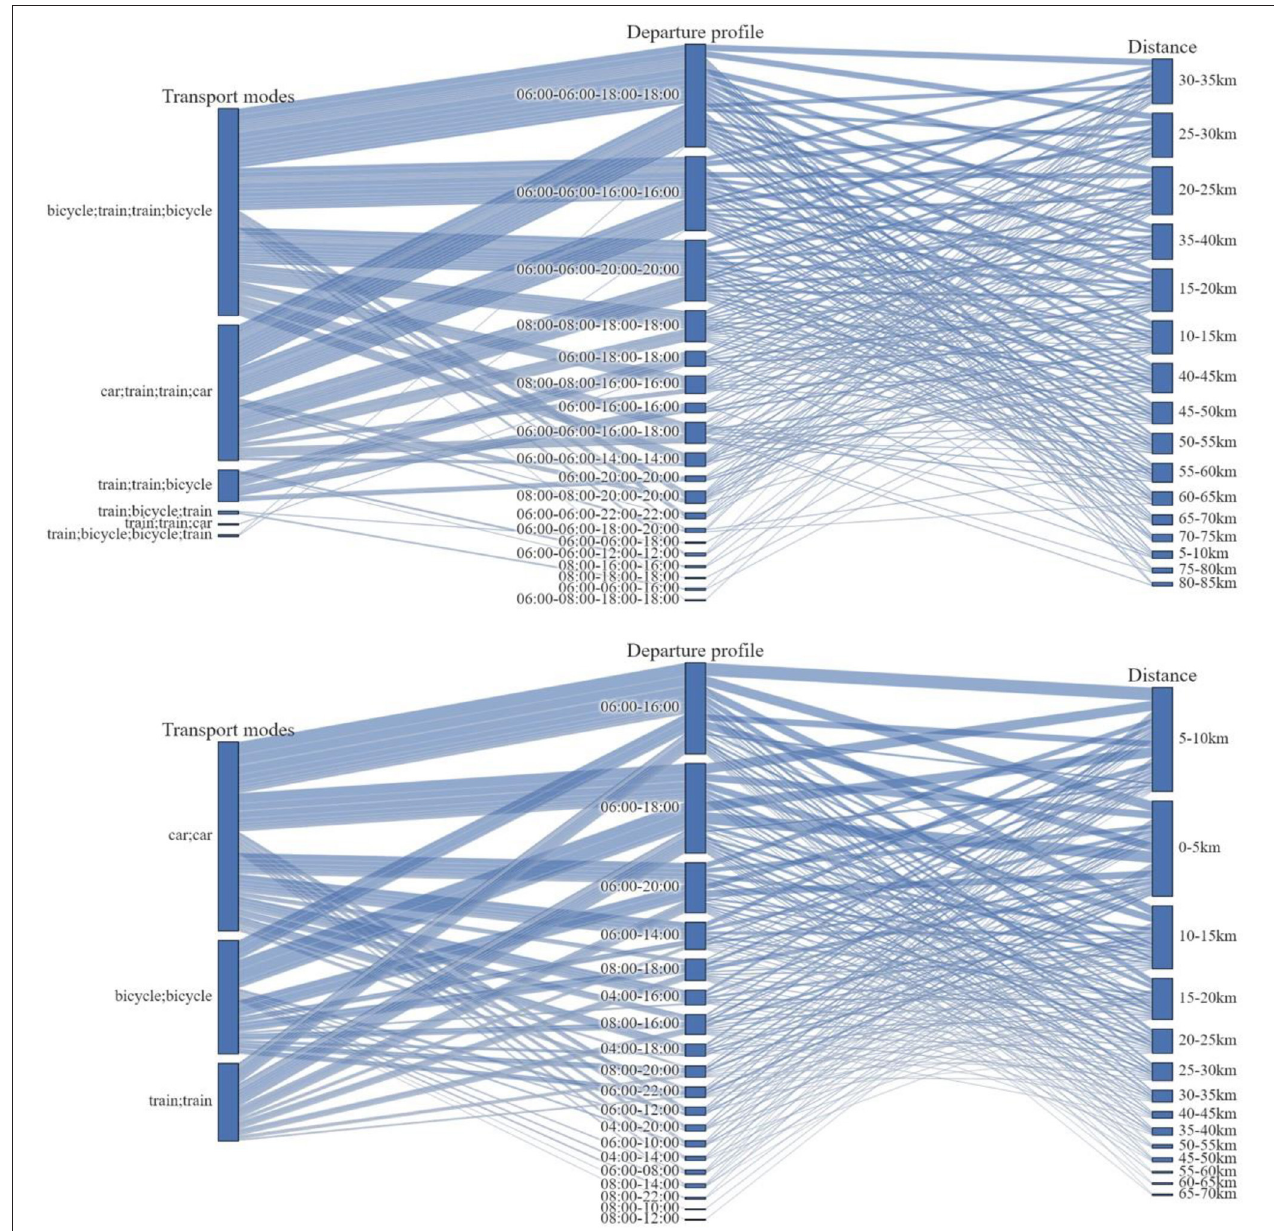
FIGURE 4 | Presentation of the three-dimensional calibration distribution for the multimodal (Top) and unimodal (Bottom)